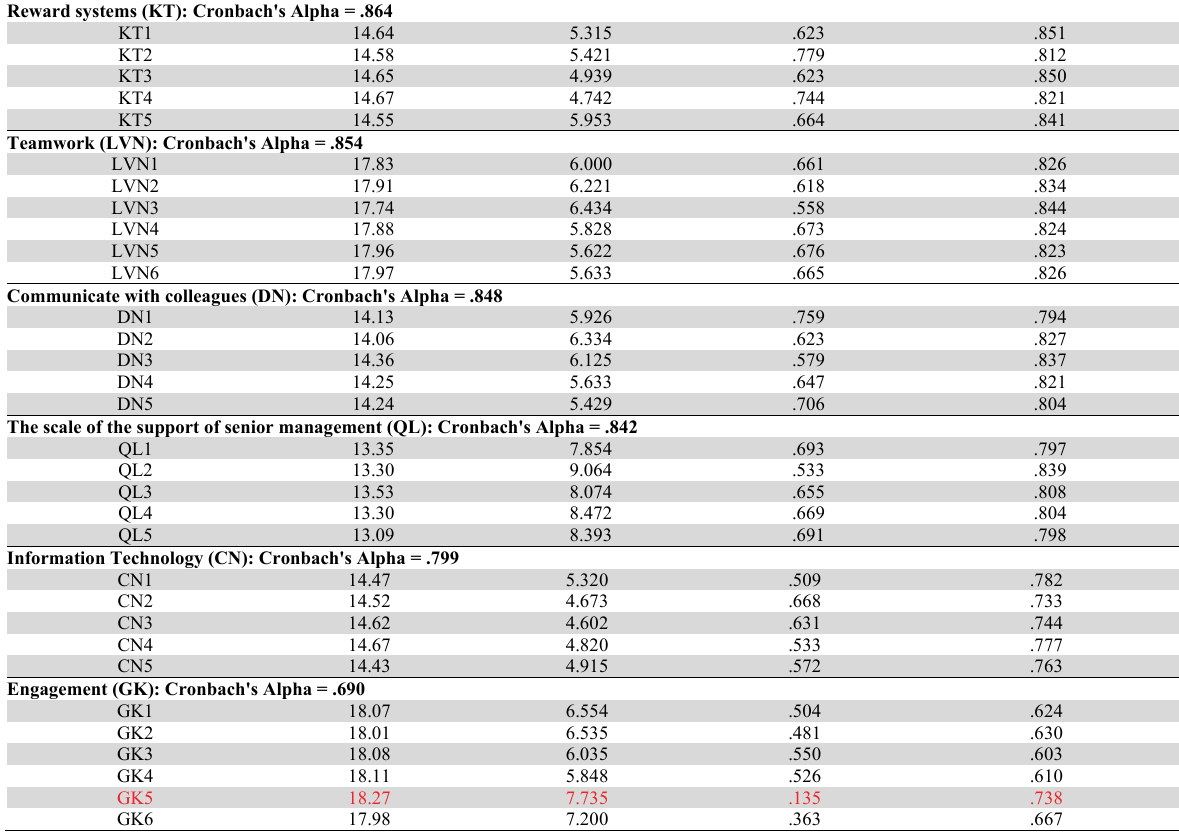
Testing of scales (Continued)